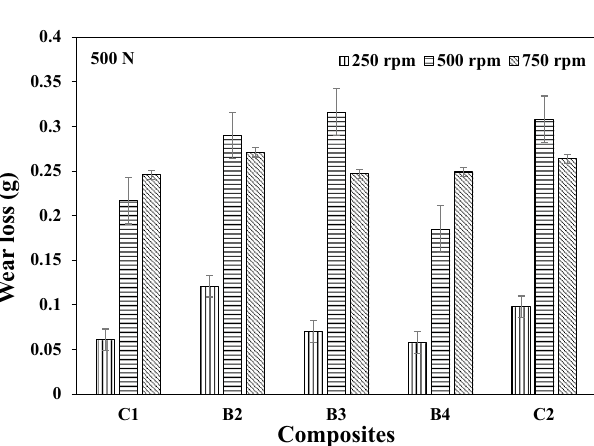
Figure 1. Wear loss at load 250 N under different speed for the composites.